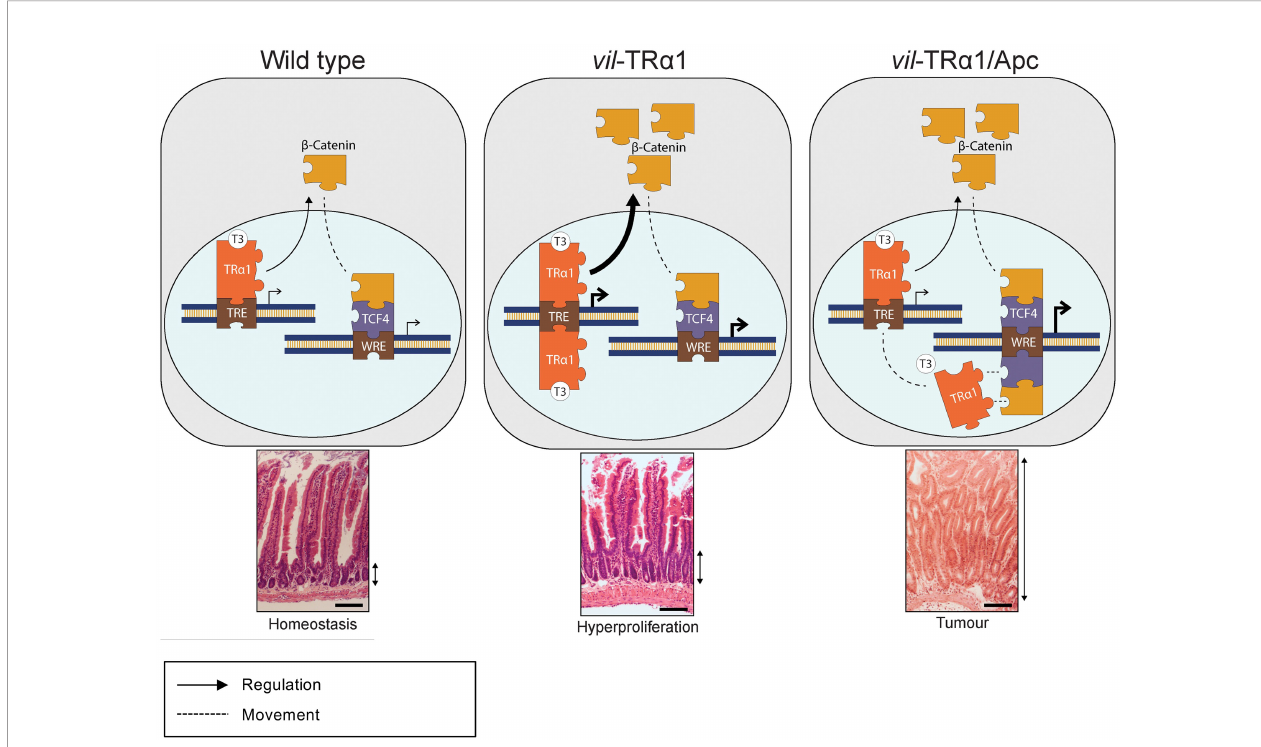
FIGURE 2 | Proposed cross-regulation of TR a 1 and Wnt effectors in normal intestine and in tumors. In physiological conditions (Wild Type panel), TR a 1 binding on TREs regulates in a positive manner the expression and stabilization of b -catenin, then contributing to maintain epithelial homeostasis. In vil -TR a 1 mice, the levels of stabilized b -catenin are increased leading to WNT activation and hyper-proliferation. In vil -TR a 1/Apc mice, the stronger b -catenin stabilization and Tcf4 overexpression might induce a competitive shift in TR a 1 binding from TREs to WREs. We can speculate that this mechanism is one of the factors responsible for the activation and/or the acceleration of the tumorigenic process dependent upon TR a 1-up regulation. TREs, Thyroid hormone response elements; WREs, WNT response elements. Solid arrows indicate genomic actions; dotted lines represent (i) the b -catenin translocation from cytoplasm to nucleus and (ii) the speculative model of TR a 1 shift from TRE to WRE. Thickness of the solid arrows indicates an increased level of transcriptional activity. Double black arrows indicate crypt width in WT and vil -TR a 1 intestinal sections or the size of the altered mucosa in vil -TR a 1/Apc